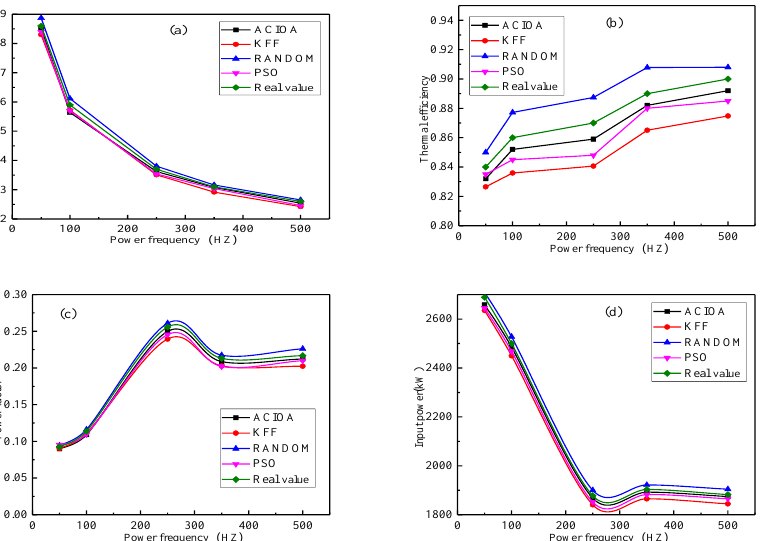
Figure 9. Effect of power frequency on circuit performance parameters. ( a ) power frequency; ( b ) thermal efficiency; ( c ) power factor; ( d ) input power.